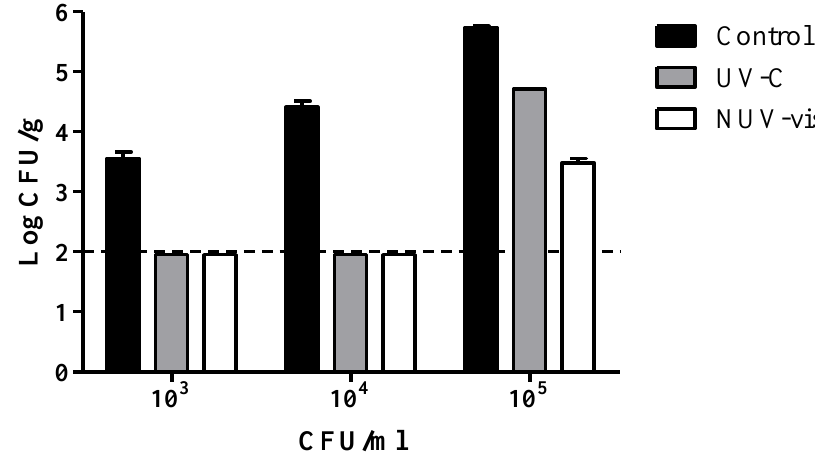
Figure 1. Mean log colony-forming units (CFU)/g of Pseudomonas spp. recorded in the preliminary test in ricotta cheese inoculated with three different concentrations (10 3 , 10 4 , and 10 5 CFU/mL) of Pseudomonas fluorescens (DSM 50090) immediately after treatments with ultraviolet light (UV-C) and near-UV–visible light (NUV–vis) at one light dose per technology, with their respective controls (inoculated and not treated). A total of 12 ricotta samples were treated once, on the same day, with UV-C and NUV–vis. The dashed horizontal line represents the detection limit (≥100 CFU/g). Each bar represents mean ± SD.